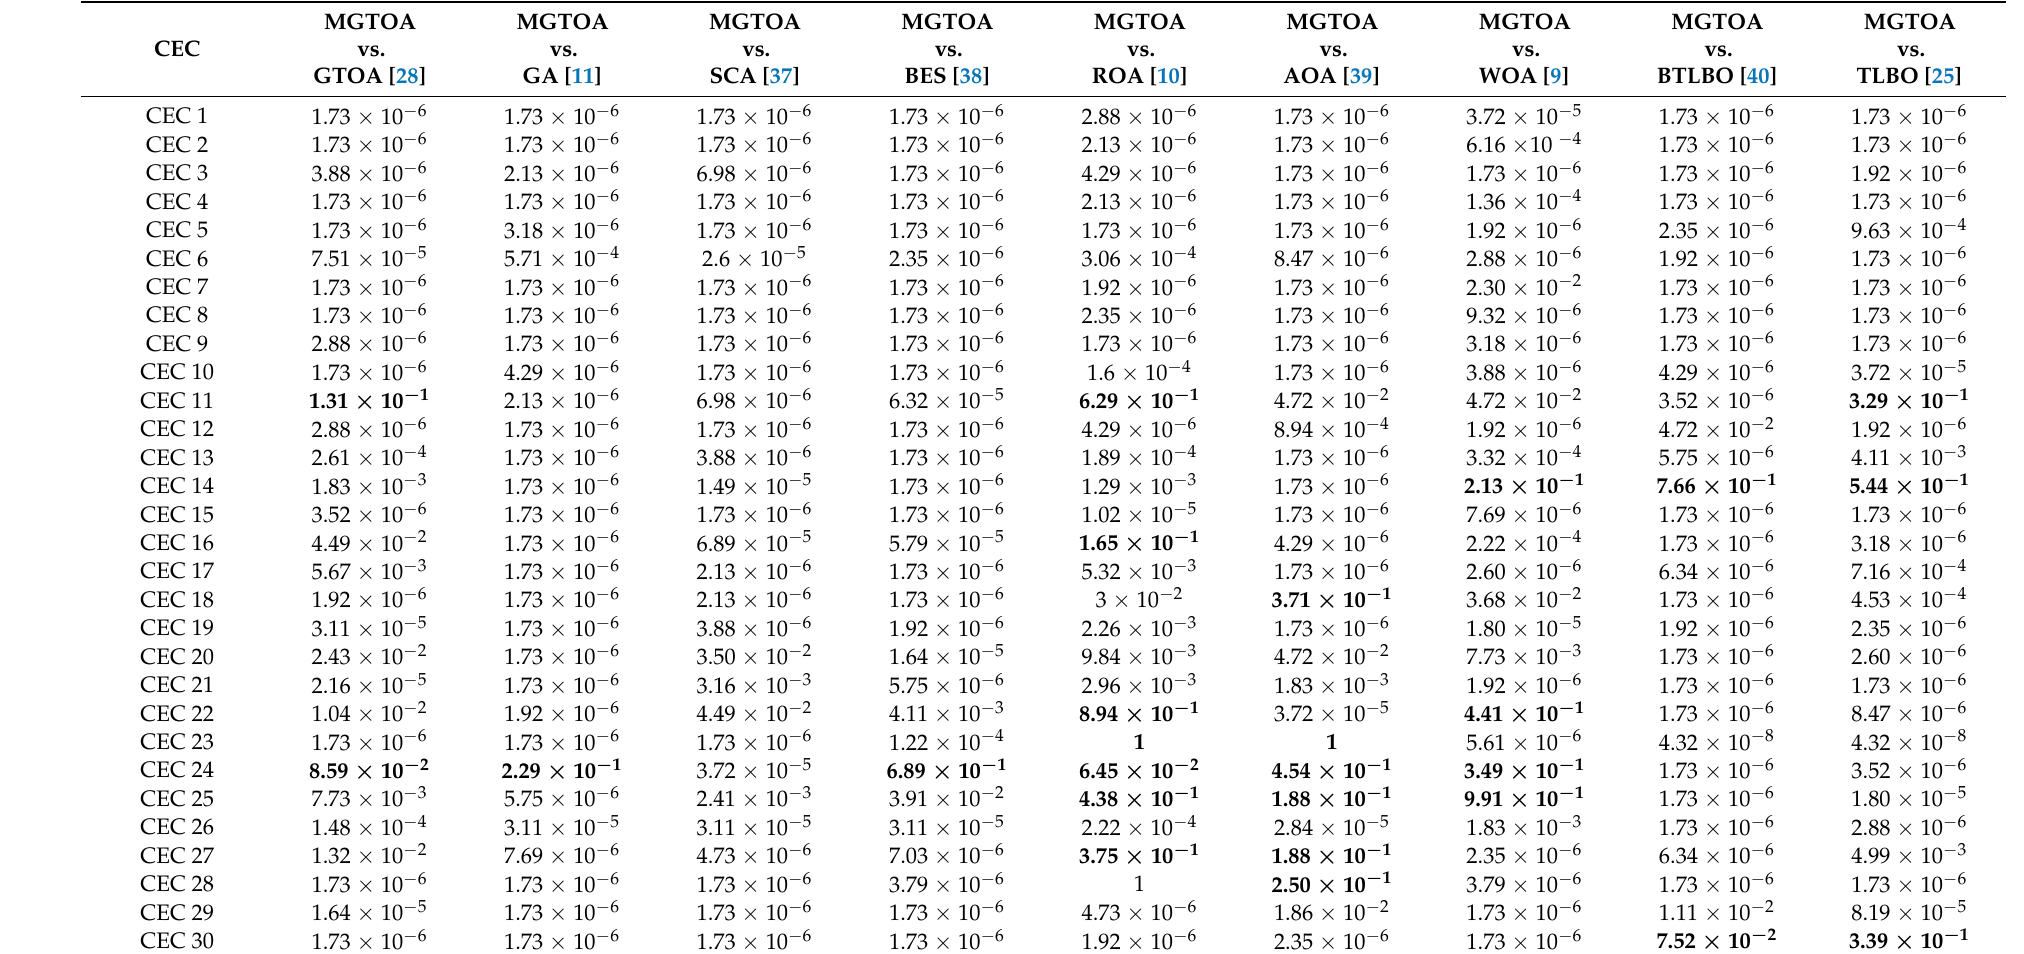
Table 9. Experimental results of Wilcoxon rank sum test on the CEC2014 test